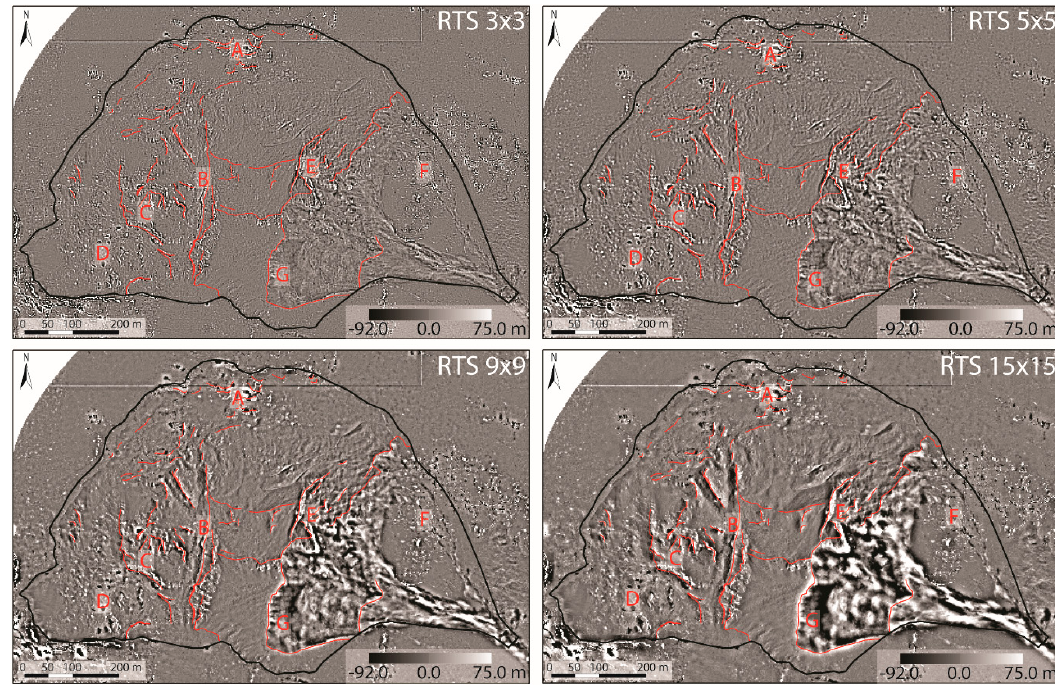
Figure 8. RTS difference maps obtained by subtracting the post- and pre-RTS maps (see the procedure in the text) for 3 × 3, 5 × 5, 9 × 9, and 15 × 15 cell moving window mean DEMs. The positive residuals are shown in black, and the negative residuals are shown in white. A–G localize the areas affected by the main morphological changes. The red lines highlight the gravity-related forms (e.g., minor crowns, lithostructural and morphological scarps, counterscarps, crests, and trenches).